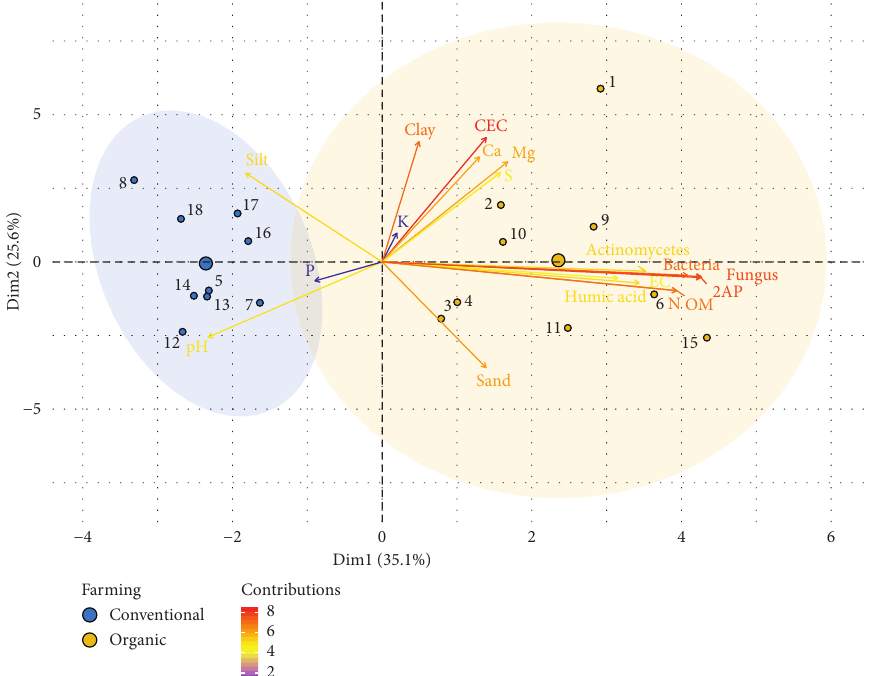
Figure 12: Principal component analysis for cultivation practices, soil properties, soil microbial population, and 2-acetyl-1-pyrroline